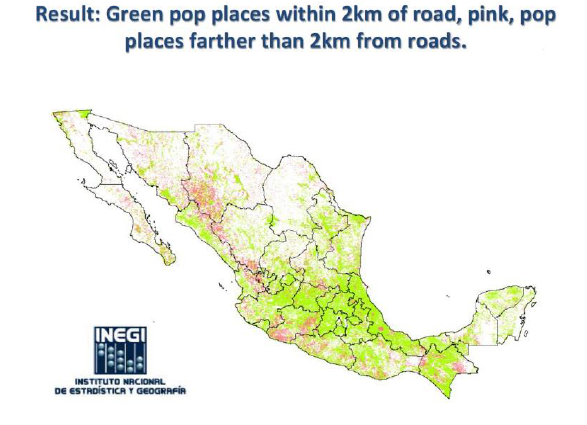
Figure 2. Mexico’s approach to Indicator 9.1.1 (Merodio,